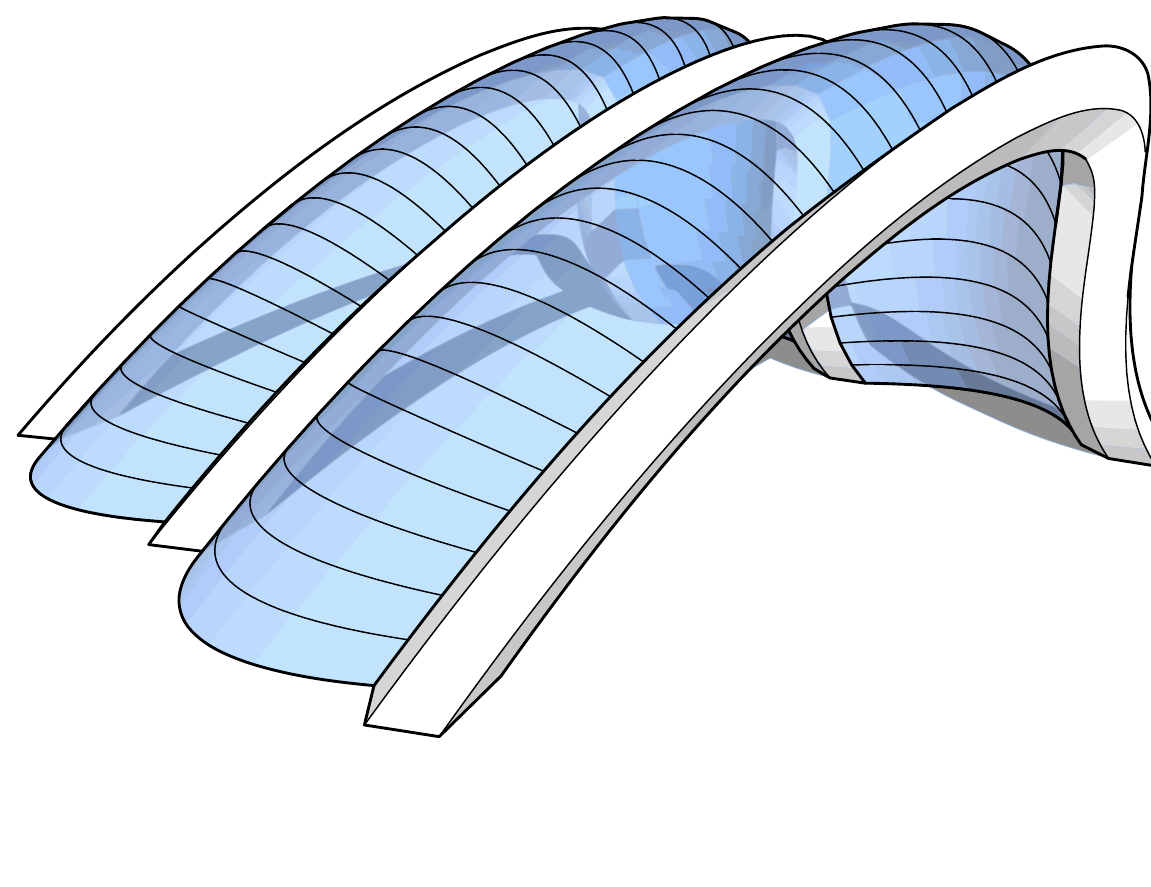
Figure 33. Mixture of method one and method three surfaces.